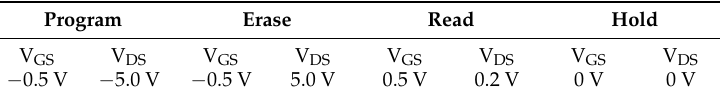
Table 1. Bias conditions for program, erase, and hold operations.